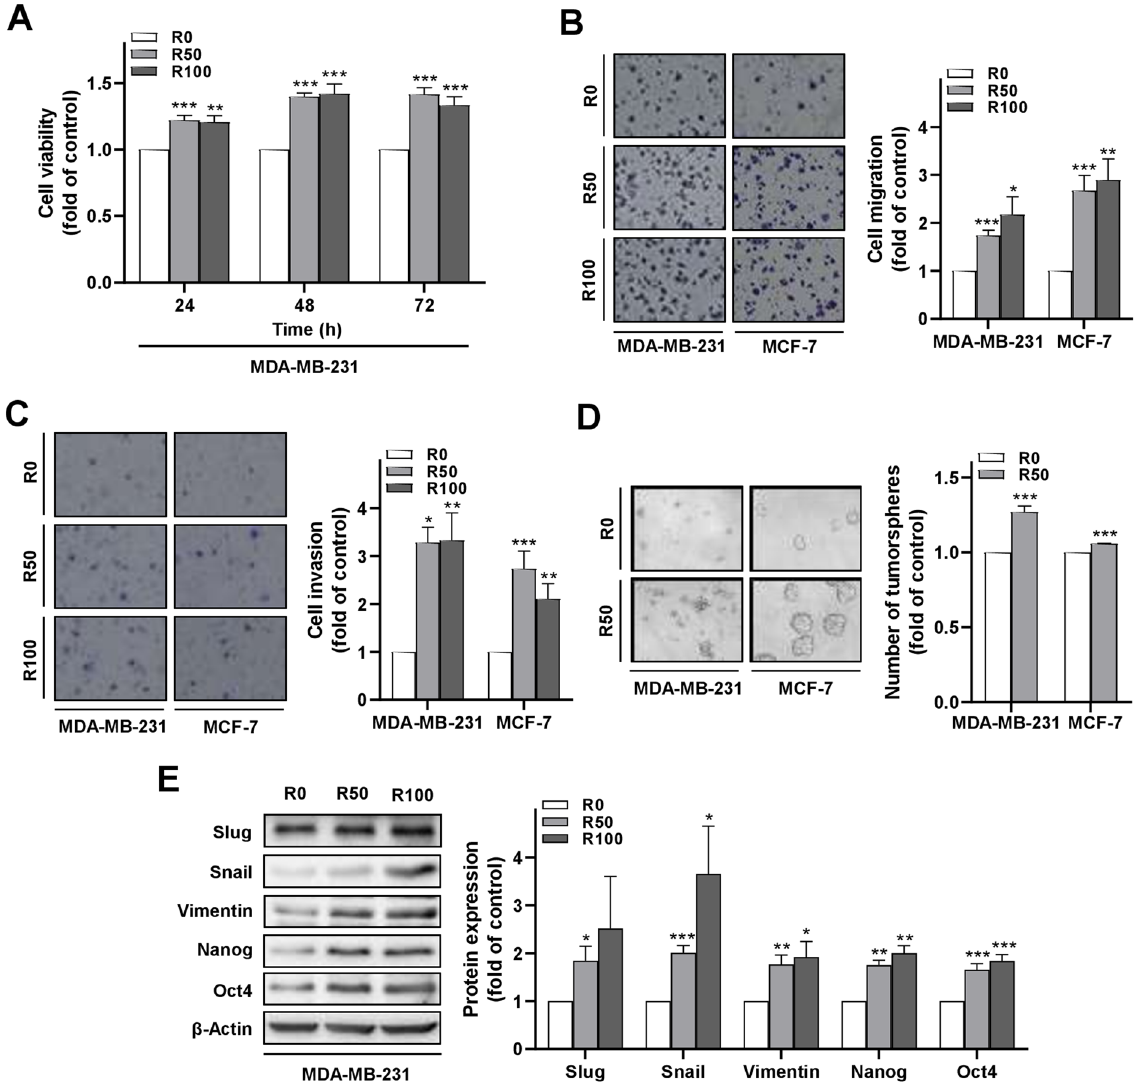
Figure 2. Enhanced malignant behaviors of breast cancer cells after co-culture with resistin-stimulated ADSCs. The isolated ADSCs were treated with resistin at 0, 50, and 100 ng/ml (R0, R50, and R100, respectively) for 48 h, followed by co-culture with MDA-MB-231 or MCF-7 cells in the transwell model for another 72 h before the following analyses. ( A ) MDA-MB-231 cells after co-culture with R-ADSCs (R50 and R100) or control ADSCs (R0) were collected and re-plated in 96-well plates for cell viability assay. ( B ) MDA-MB-231 or MCF-7 cells after co-culture with R-ADSCs (R50 and R100) or control ADSCs (R0) were collected and re-plated in the transwell inserts for cell migration assay. ( C ) MDA-MB-231 or MCF-7 cells after co-culture with R-ADSCs (R50 and R100) or control ADSCs (R0) were collected and re-plated in the transwell inserts coated with Matrigel for cell invasion assay. ( D ) MDA-MB-231 or MCF-7 cells after co-culture with R-ADSCs (R50) or control ADSCs (R0) were collected and re-plated in ultra-low attachment microplates for tumorsphere formation assay. Quantitation was carried out for those with diameter over 50 μm. ( E ) MDA-MB-231 cells after co-culture with R-ADSCs (R50 and R100) or control ADSCs (R0) were collected and analyzed for protein expression of mesenchymal markers (Slug, Snail, and Vimentin) and cancer stemness markers (Nanog and Oct4) by Western blot. The original blot images were available in Supplementary Information, and these blots were cut from full-length membranes prior to hybridization with the corresponding antibodies. Data were obtained from three independent experiments and presented as mean ± SEM. Statistical difference was determined by t-test comparing R50 or R100 group versus their corresponding R0 group as control. * p < 0.05; ** p < 0.01; *** p <